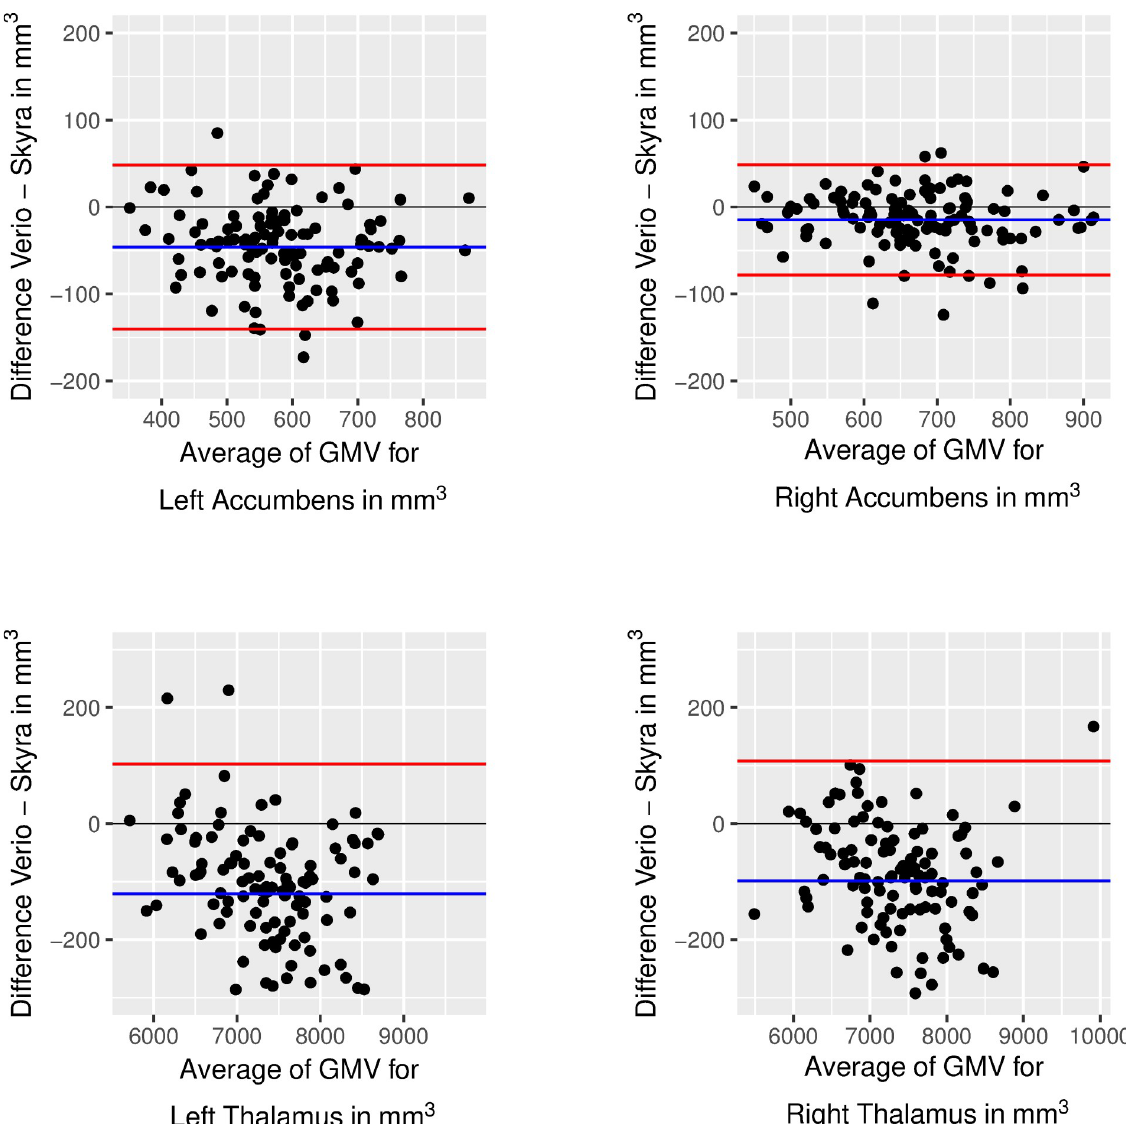
Fig 7. Bland-Altman plot showing differences of Verio ND–Skyra ND against means for left Accumbens (top row) and left Thalamus (bottom row). Limits of agreement at 95% of standard